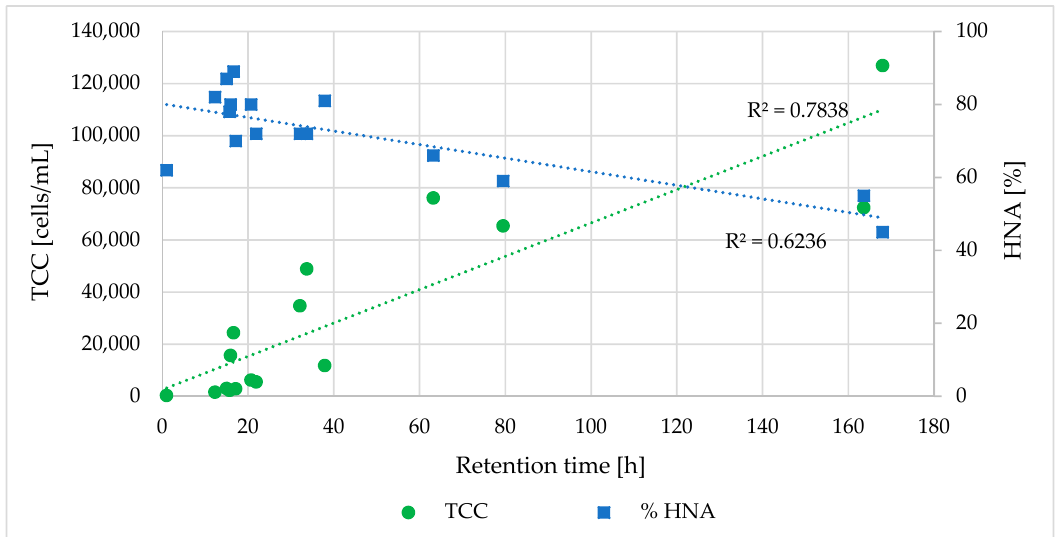
Figure 6. Correlation between retention time and TCC (green dots), as well as %HNA bacteria (blue squares).